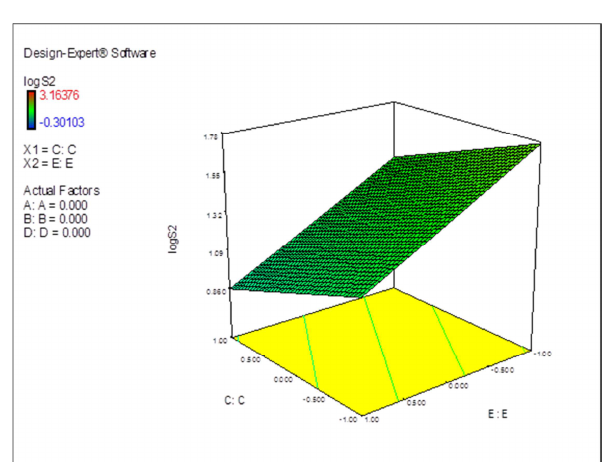
Figure 2 – Variability logS 2 of the output, as a function of the factors E and C